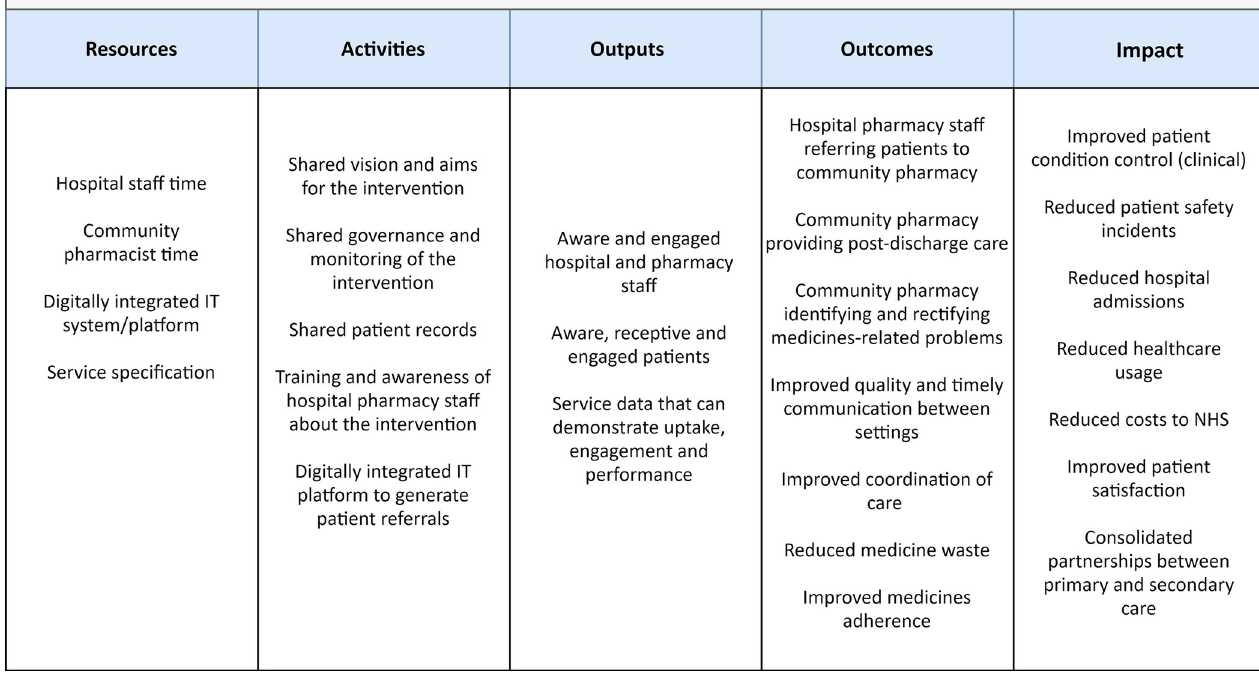
Fig 2. A logic model of the ToC